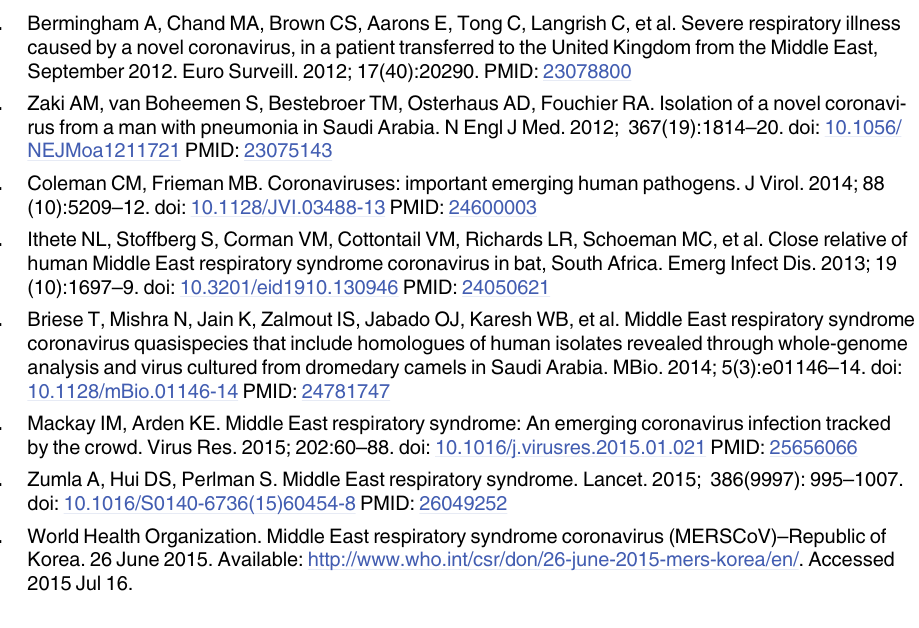
S2 Fig. Emini surface accessibility prediction of the N protein of MERS-CoV. X-axis repre- sents the amino acids, whereas Y-axis represents accessible propensity. Average antigenic score was 1.000. Area displayed by the threshold line is considered as potential B-cell accessible regions. S3 Fig. Karplus and schulz flexibility prediction of the N protein of MERS-CoV. X-axis rep- resents the amino acids, whereas Y-axis represents flexible propensity. Average antigenic score was 1.028. Area displayed by the threshold line is considered as potential B-cell flexible regions. S1 Table. Antigenic scores of the entire proteomes of all MERS-CoV isolates. S2 Table. 9-mer peptide core sequences in the N protein of MERS-CoV are predicted to be helper T-cell epitopes using the NetMHCIIpan 3.0 web server. S3 Table. 9-mer peptide sequences in the N protein of MERS-CoV are predicted to be CTL epitopes using the IEDB MHC-I binding prediction web